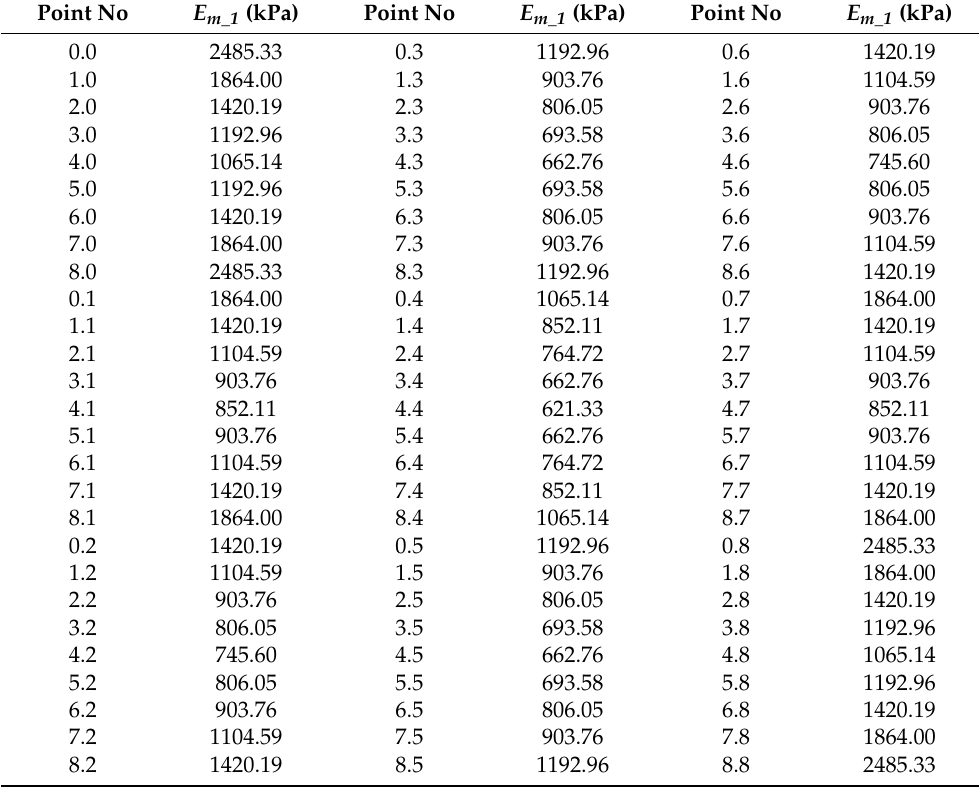
Table 2. The results of the constrained modulus of elasticity of the peat materials at the calculation point are determined by the first